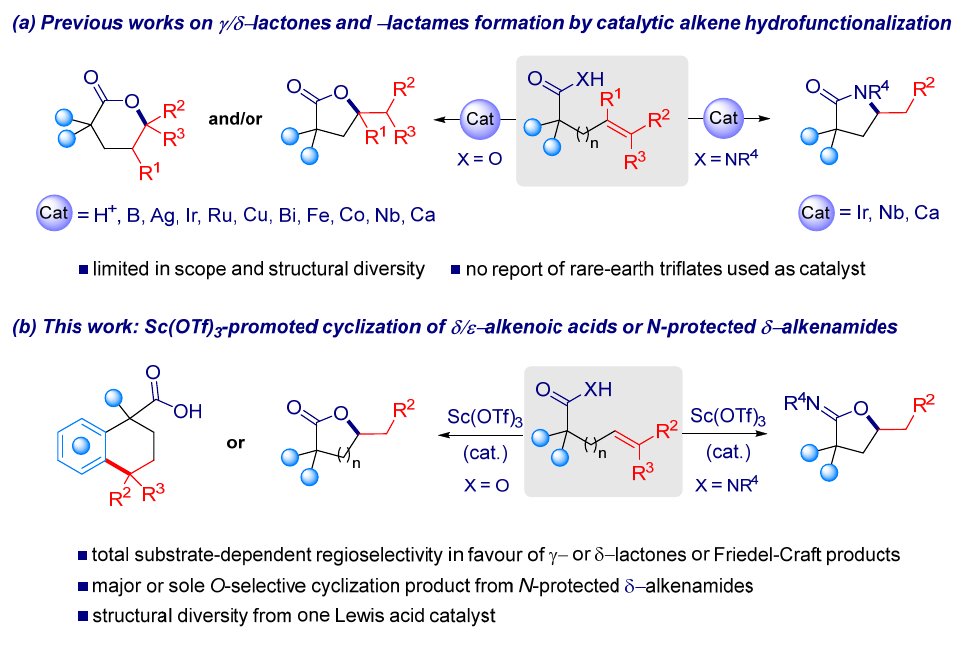
Figure 1. ( a ) Previous works on γ / δ -lactones and -lactames formation by catalytic alkene hydrofunc- tionalization and ( b ) this work.